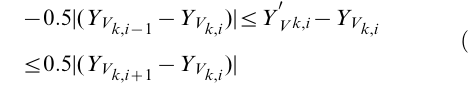
Sample Before(mm) After(mm)